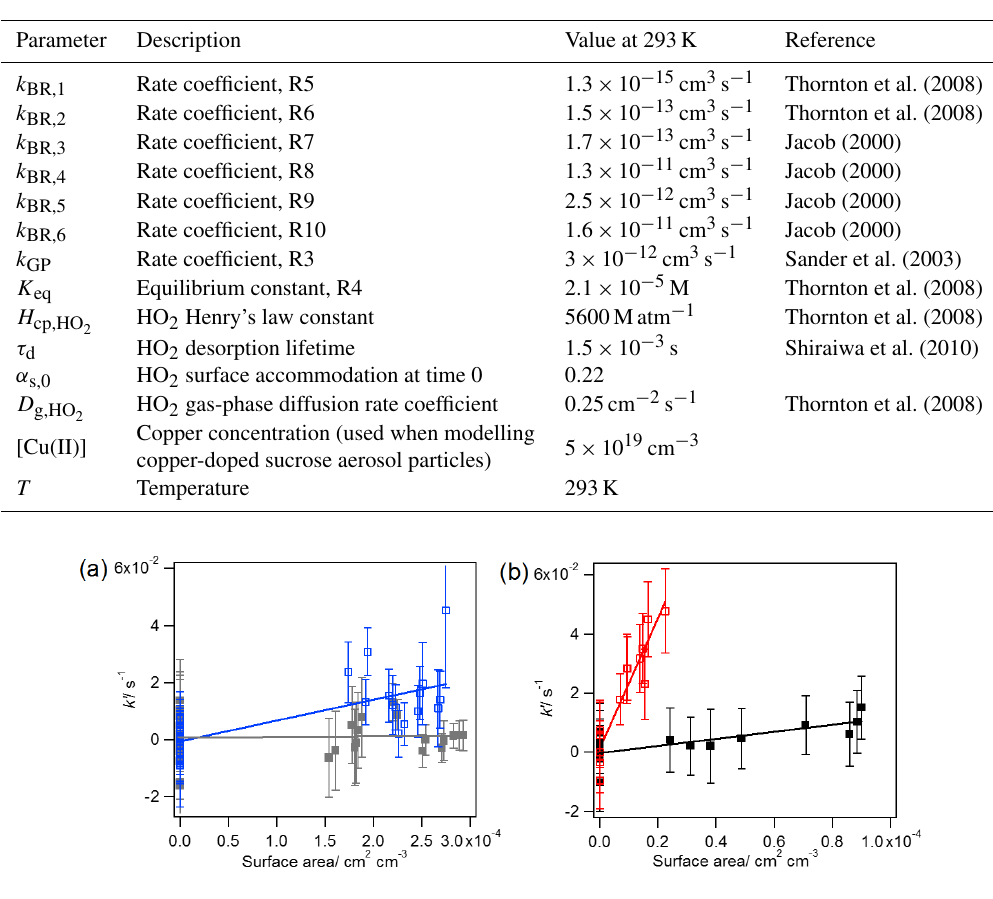
Figure 4. The pseudo first-order rate coefficients with the wall losses subtracted as a function of aerosol surface area for (a) α -pinene- derived aerosol particles (grey) and TMB-derived aerosol particles (blue) at 50% RH and a pressure of 904–929mbar and (b) copper-doped sucrose aerosol particles at 17% RH (black) and 71% RH (red) at atmospheric pressure. Experiments were performed at 293 ± 2K. In (a) experiments were performed using the PAM chamber as the source of aerosol particles and represent experiments 5 and 6 in Table 2. Error bars represent the 1SD (standard deviation) propagated uncertainty for individual determinations of k (cid:48) . The data points at an aerosol surface area of 0cm 2 cm − 3 (no aerosol particles present) are repeats of the wall loss decays taken throughout the experiment and are within error of each